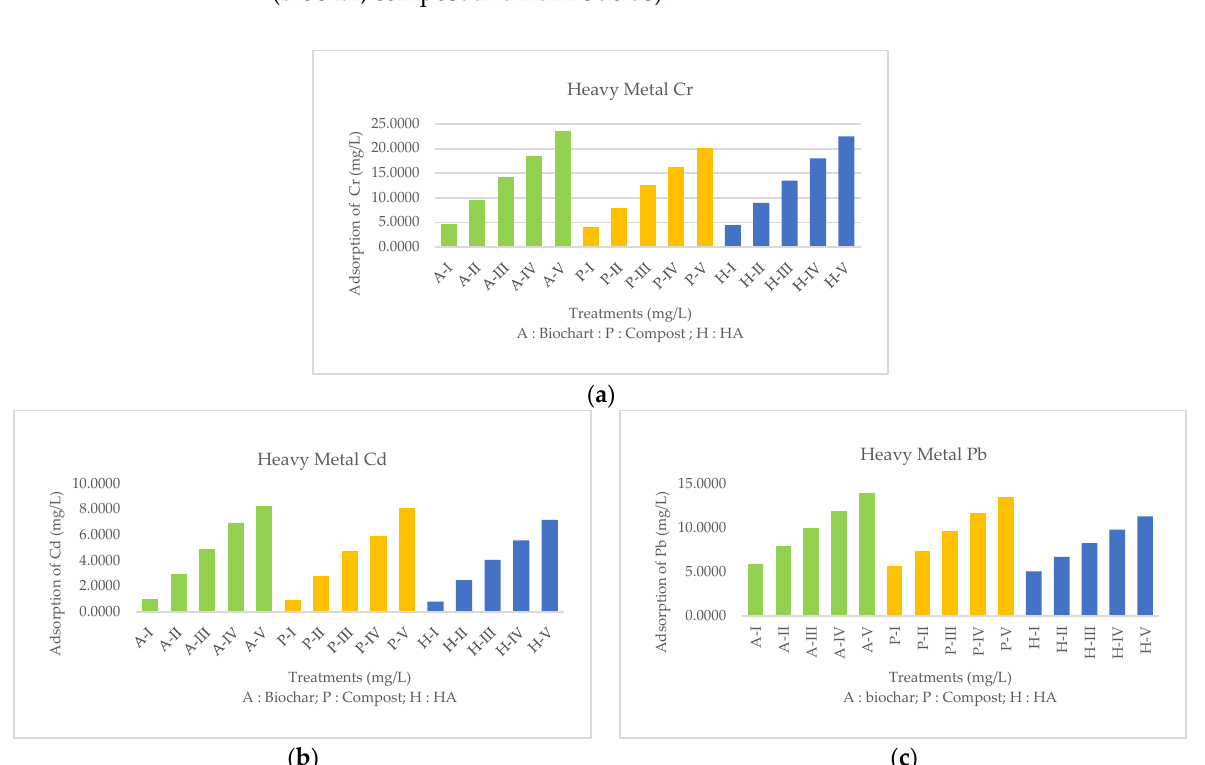
Figure 6. The adsorption of heavy metals Cr ( a ), Cd ( b ) and Pb ( c ) at various concentrations of metals.